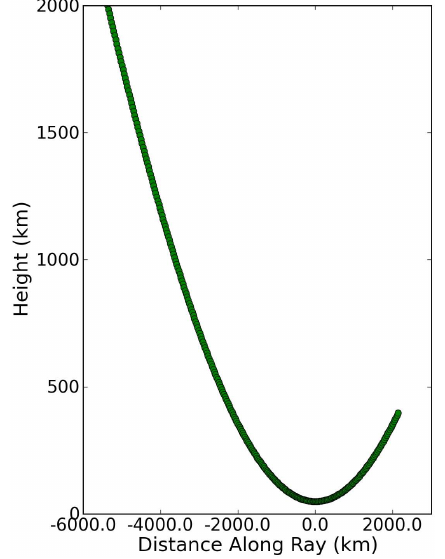
Fig. 1. The altitude of the simulated ray versus distance along the ray, starting at 2000km altitude. Zero distance is at the ray tangent point. The receiver is on-board CHAMP (400km altitude orbit).